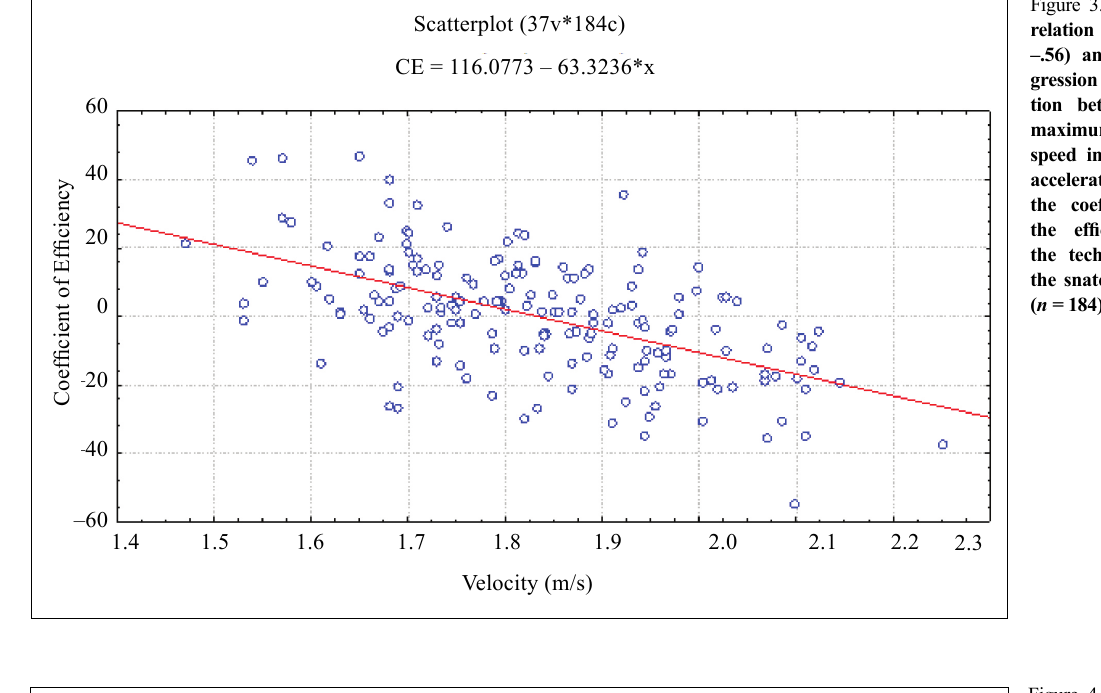
Figure 4. The cor - relation field ( r = – .65) and the re - gression equation between the maxi - mum of the rela- tive power and the coefficient of the efficiency of the techniques in the snatch in men ( n =